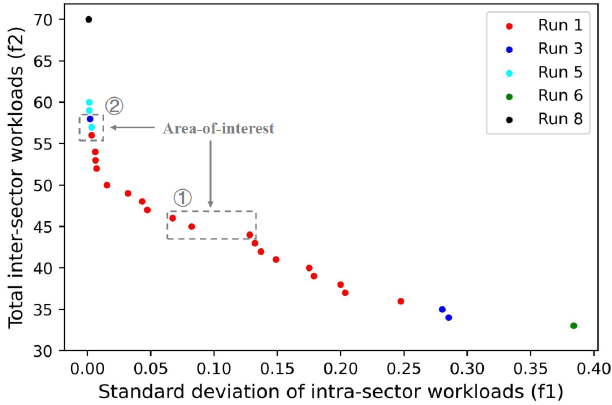
Figure 7. Non-dominated solutions of the proposed framework.